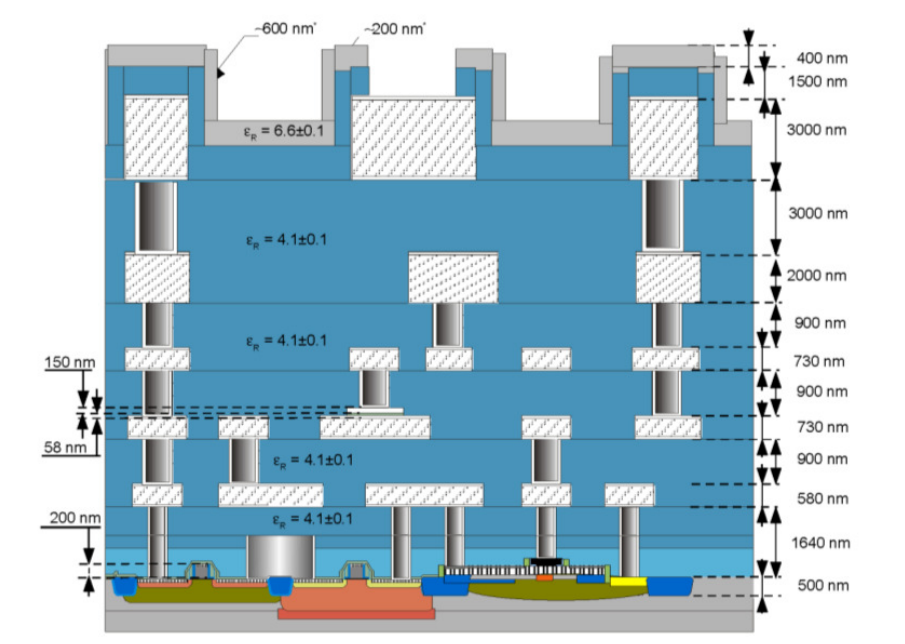
Figure 1. IHP SG25 process cross-section (taken from [9] with